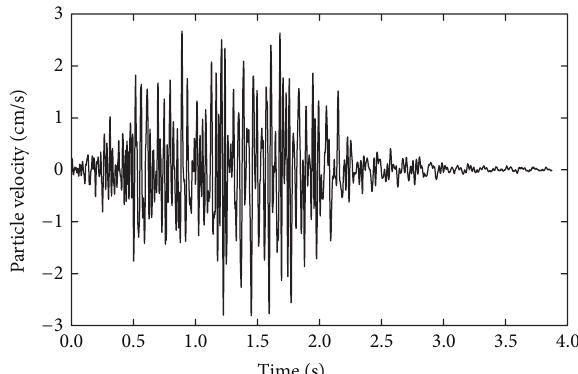
Figure 1: Bilinear restoring force model.